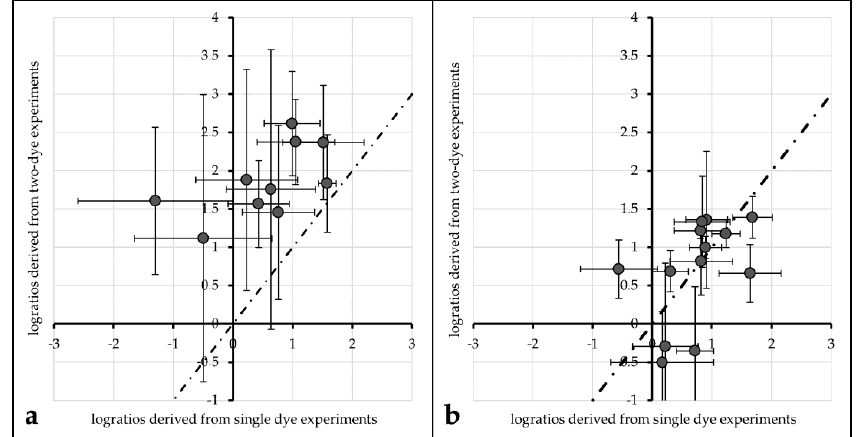
Figure 6. Comparison of log 2 -ratios derived from single-dye spots (635 nm intensity from Cy3 vs. unlabeled, 532 nm intensity from unlabeled vs. Cy5) plotted against log 2 -ratios derived from two-dye spots for unprotected spots of Array2 ( a ) and spots protected by 10 mM ROXS in PBS ( b ). The dotted line passes the origin with a slope of 1.